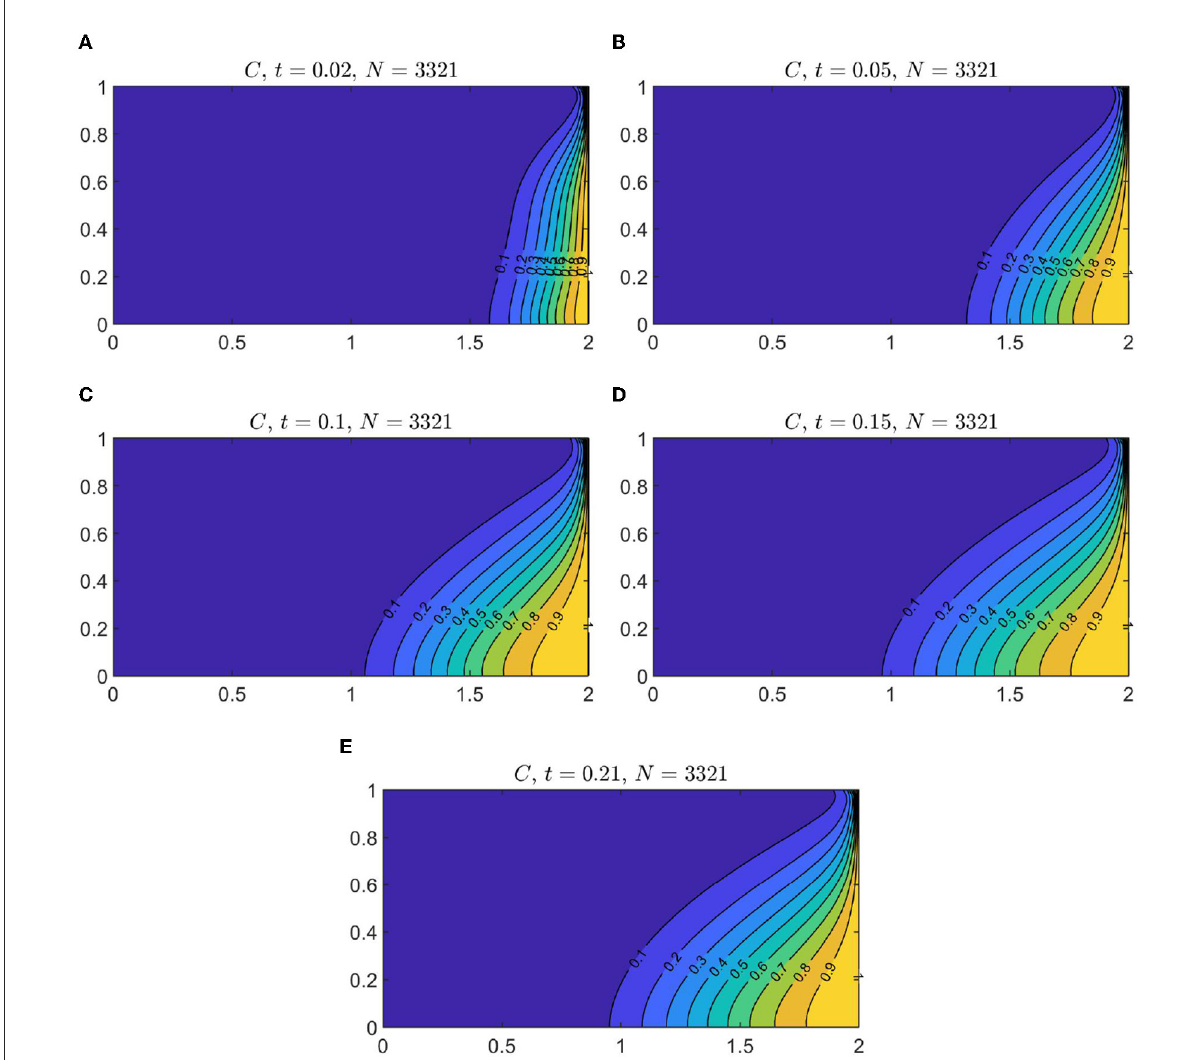
FIGURE7 Concentration lines distribution at different time for the original Henry problem. (A) t = 0.02, (B) t = 0.05, (C) t = 0.10, (D) t = 0.15, (E) steady-state t = 0.21 ( a = 0.2637, b = 0.1, N = 81 × 41 = 3,321).